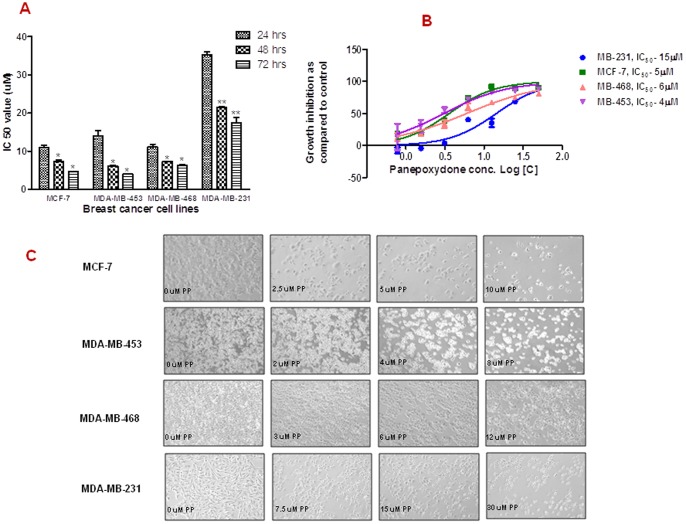
Inhibitory effects of panepoxydone on the proliferation of human breast cancer cells.MCF-7, MDA-MB-231, MDA-MB-468 and MDA-MB-453 breast cancer cells were grown in 96 well microtitre plates (5000 cells/well) and treated with increasing concentrations of PP or with DMSO (0.2% vehicle control) and analyzed by CellTiter Glow assay. (A) Time-dependent anti-proliferative effect of PP on breast cancer cells. Data are presented as the means ± SD (n = 2). (B) Dose-dependent anti-proliferative effect of PP on breast cancer cells after 72 hrs. Data are presented as the means ± SD (n = 4). PP inhibited cell viability in a dose-dependent manner for all the cell types suggesting anti-cancer activity of PP. (C) Morphological changes of breast cancer cells after treatment with PP. Based on the IC50 value, 3 doses were selected for subsequent experiments: D1 (half of IC50, D2 (IC50) and D3 (2×IC50). Cells (1.5×104 cells/well) were seeded in 6-well plates and incubated with increasing concentrations of PP or DMSO (0.2% vehicle control) for 24 hrs. Morphological changes were observed under the inverted phase-contrast microscope and photographed. Representative micrographs are from one of the random fields of view (magnification 200X) of cells.